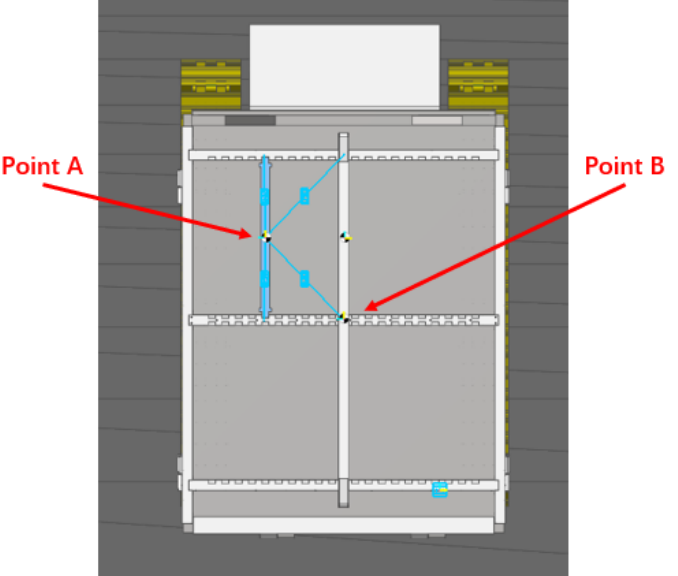
Figure 7. Top view diagram used for calculating relative the coordinates when the bee frame is loaded, where points A and B denote the centers of mass of the bee frame and loading box, respectively.